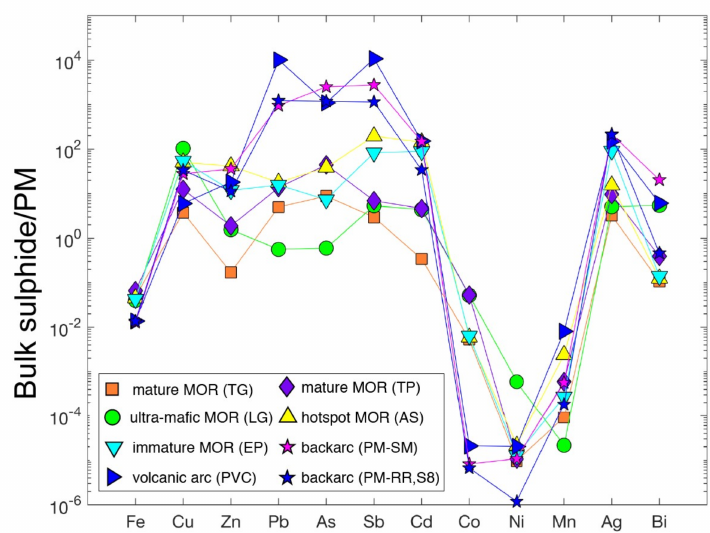
Figure 9. Bulk metal pattern (wt %) for the hydrothermal fields analysed in this study, split for Pacmanus into Satanic Mills where a magmatic fluid source is prevalent and Roman Ruins/Solwara-8 where it is not. Bulk metal pattern calculated based on average elements in each sulfide mineral normalised to modal sulfide mineral abundance according to XRD semi-quantitative data of each